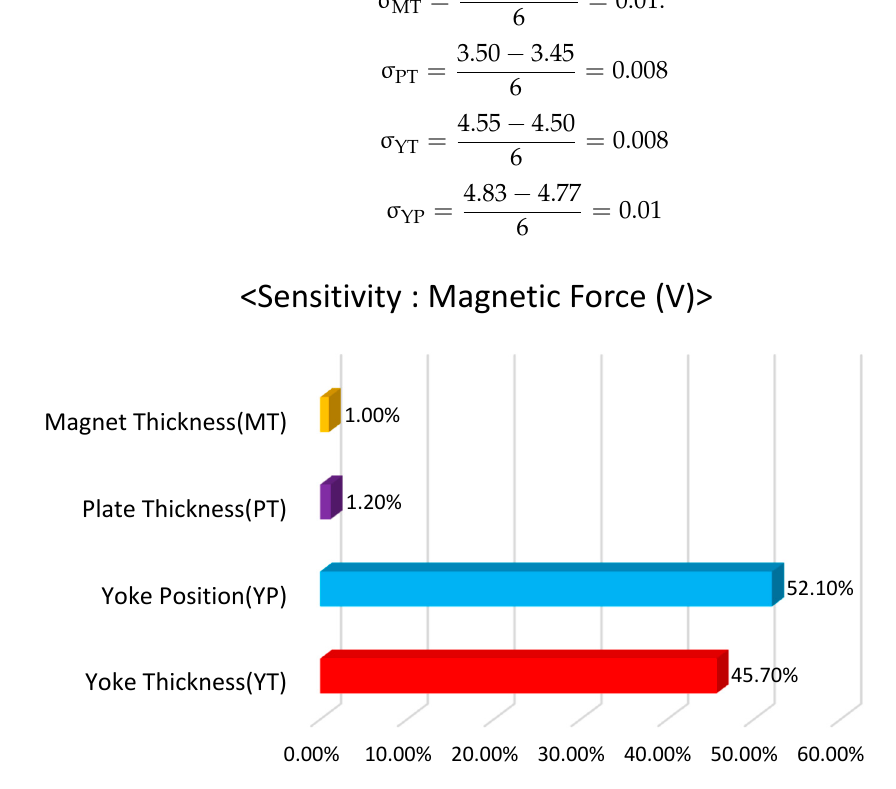
Figure 19. Analysis results of sensitivity by performance factor.